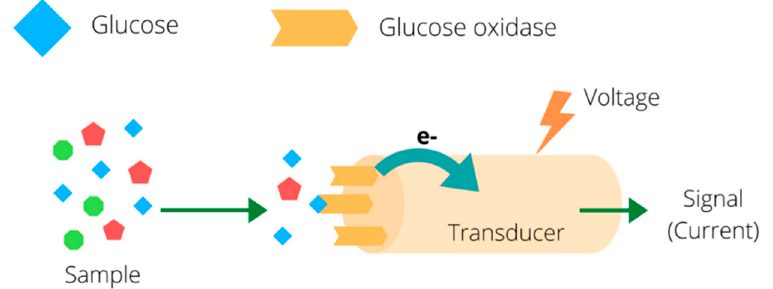
Figure 2. Scheme of an amperometric glucose biosensor.